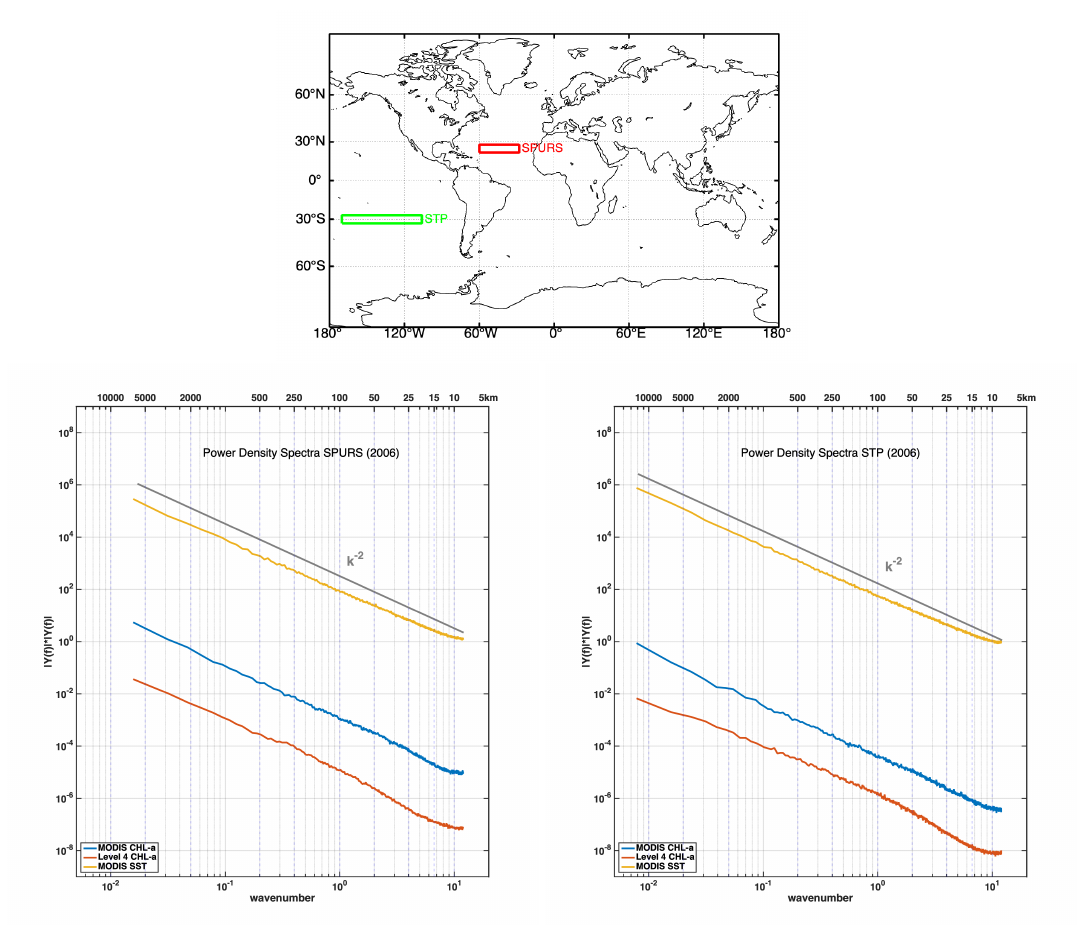
Figure 5. ( top ) Areas for power density spectra (PDS) computation: Red box represent SPURS region (22 ◦ –28 ◦ N and 28 ◦ –60 ◦ W) and green box represent STP region (27 ◦ –33 ◦ S and 106 ◦ –170 ◦ W). ( bottom ) Median of PDS for the year 2006 of MODIS L3 SST, MODIS Chl- a , and Level 4 Chl- a for the SPURS region ( left ) and the STP region ( right